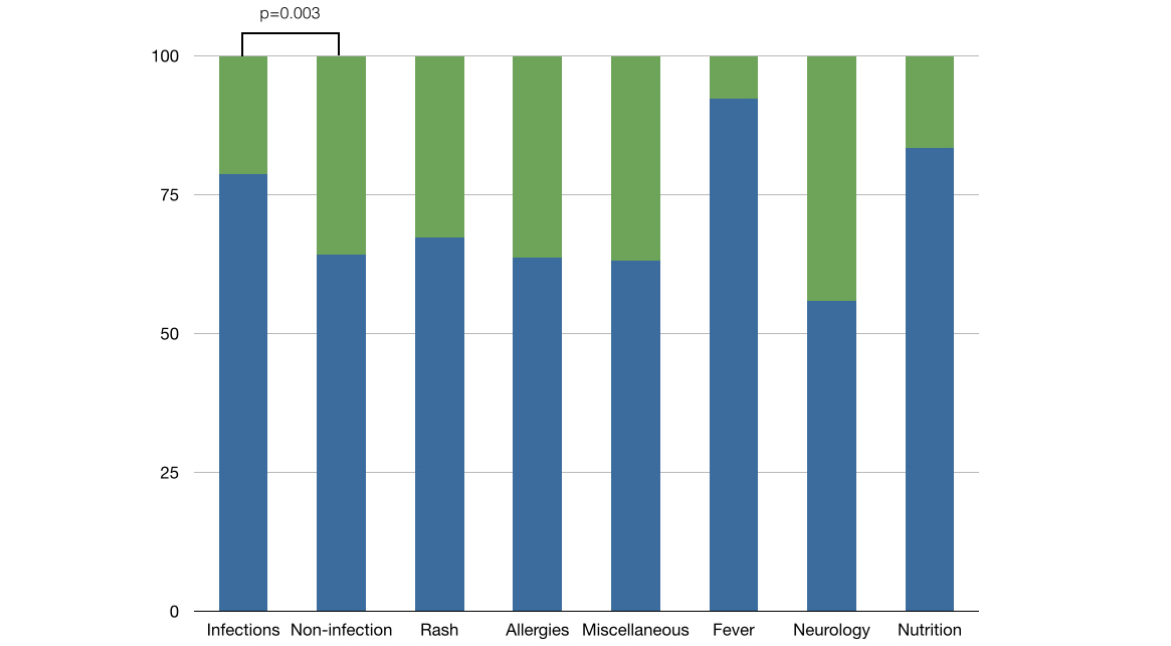
Figure 3. The proportion (%) of questions comprehensively answered (in blue) and the proportion requiring further contact with a health care worker (in green); P=.003 for the difference between questions comprehensively answered in the infections category and the non-infection